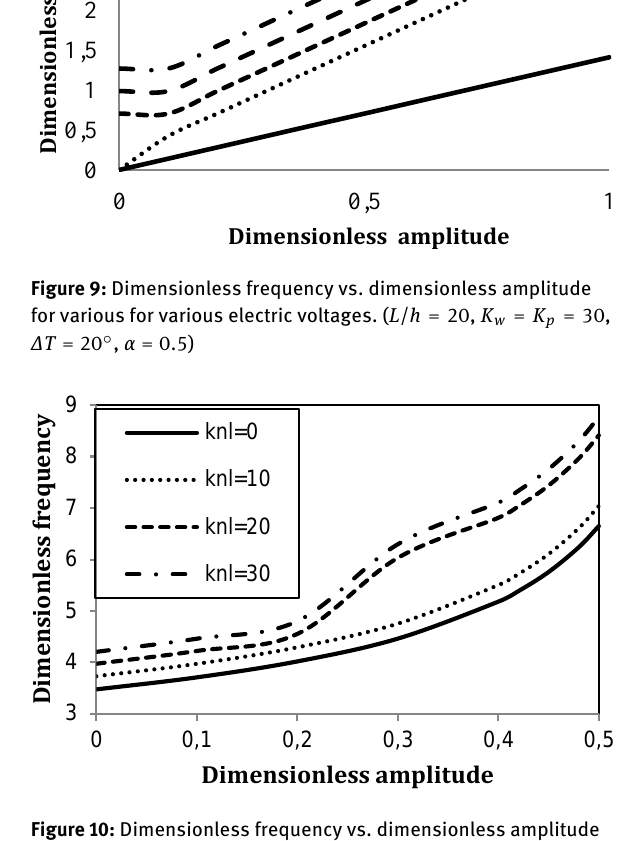
Figure 10: Dimensionless frequency vs. dimensionless amplitude for different nonlinear foundation values. ( L / h = 10 , V = 0 , K w = K p = 10 , ∆T = 10 ∘ , α = 0.5 )